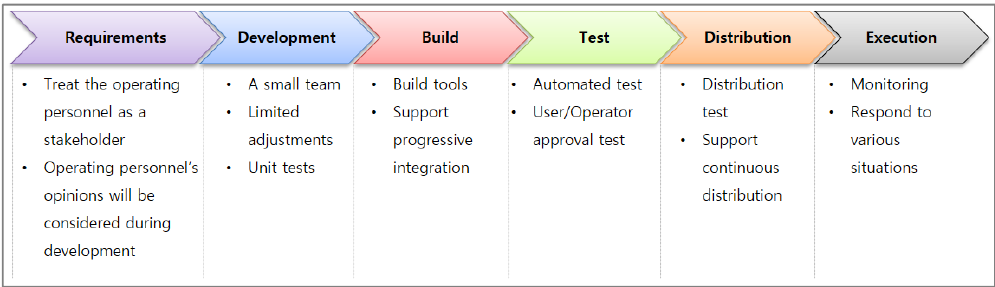
Figure 8. Life cycle of DevOps (Porter, 2015).